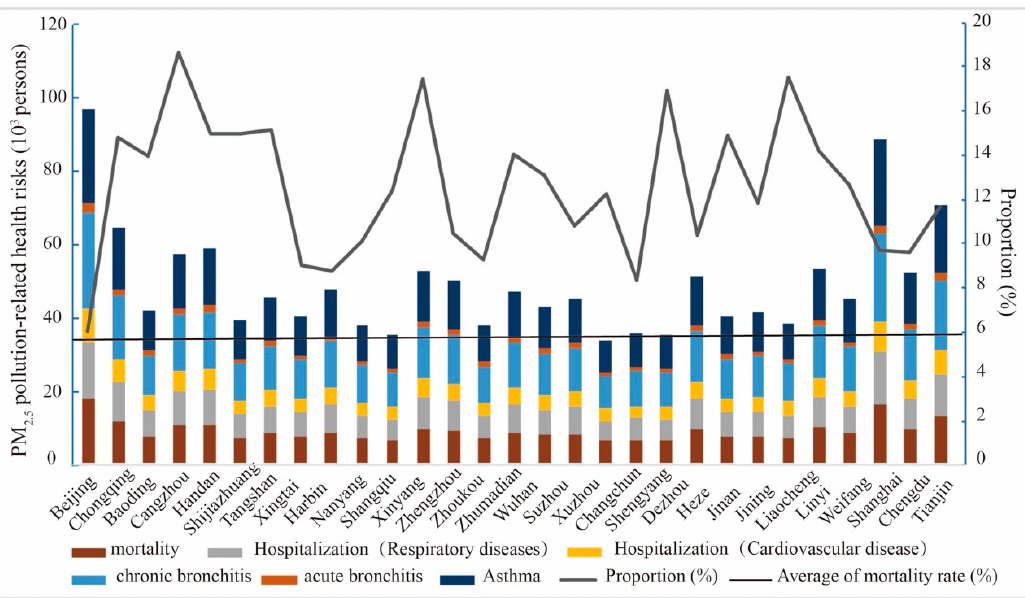
Figure 4. PM 2.5 -related health outcomes change and mortality in the top 30 cities.